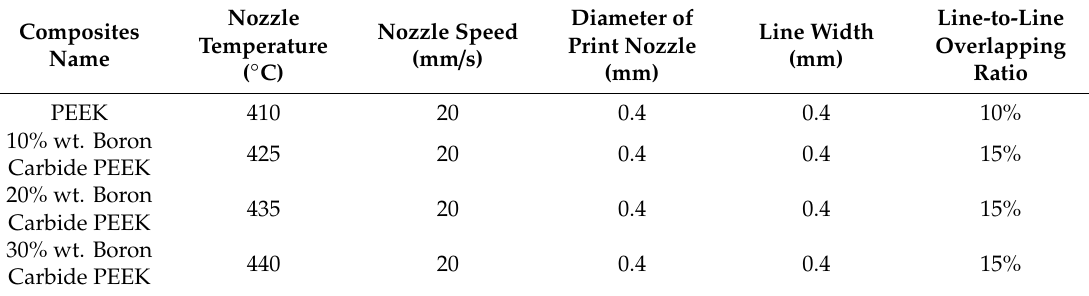
Table 2. FDM processing parameters of boron carbide PEEK.